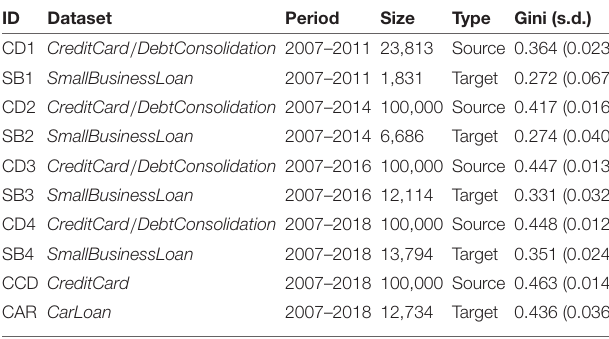
TABLE 1 | The datasets used in the transfer learning studies are listed